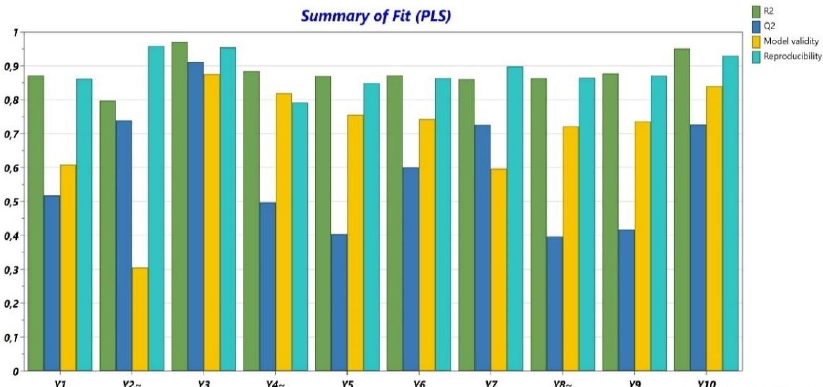
Figure 1. Summary of fit (R 2 , Q 2 , model validity, and reproducibility). Table 5. Quality of fit (R 2 adjusted and RSD) and the ANOVA test.